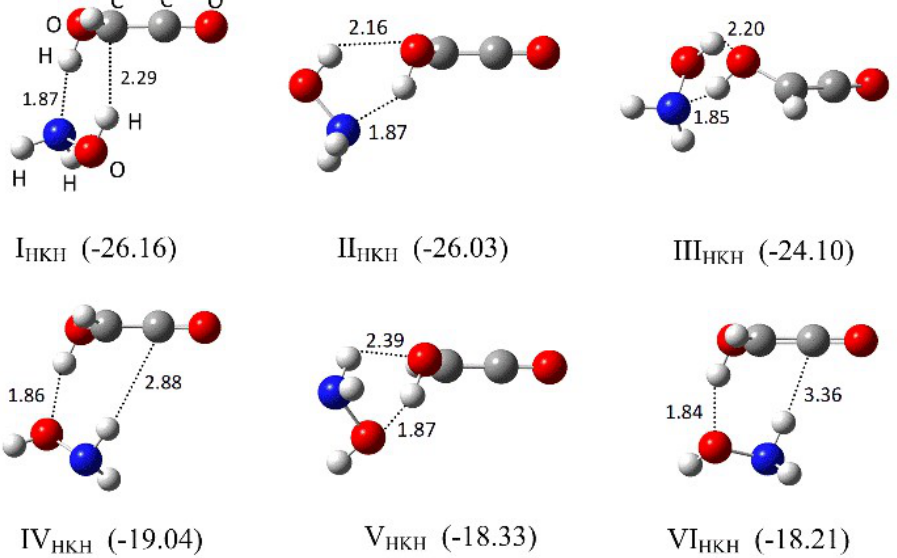
Figure 3. The MP2/6-311++G(2d,2p) optimized structures of the six most stable hydroxyketene– hydroxylamine complexes. The ∆E CP (ZPE) binding energies in kJ mol −1 are given in parentheses. The intermolecular distances are given in Å.